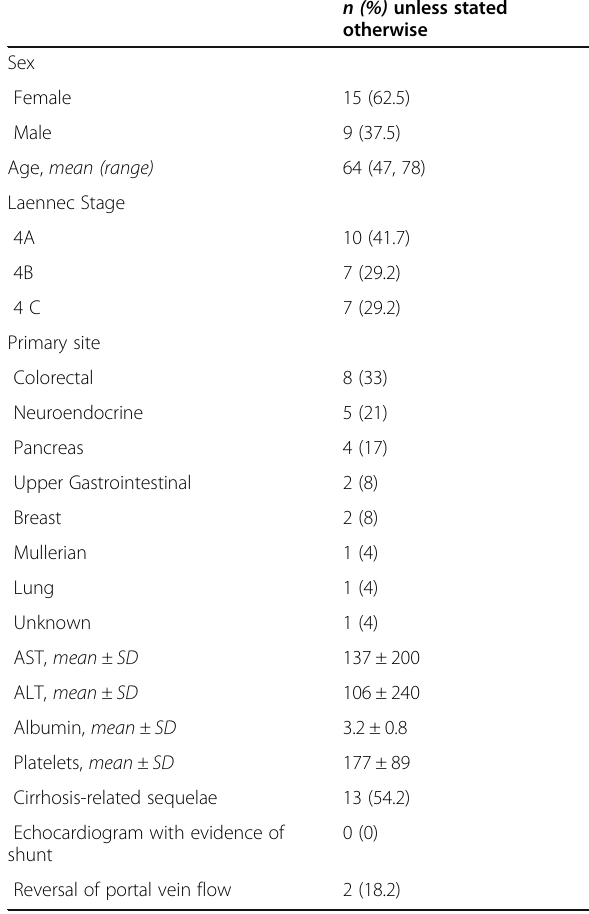
Table 2 Summary of clinicopathologic features of metastases in cirrhosis